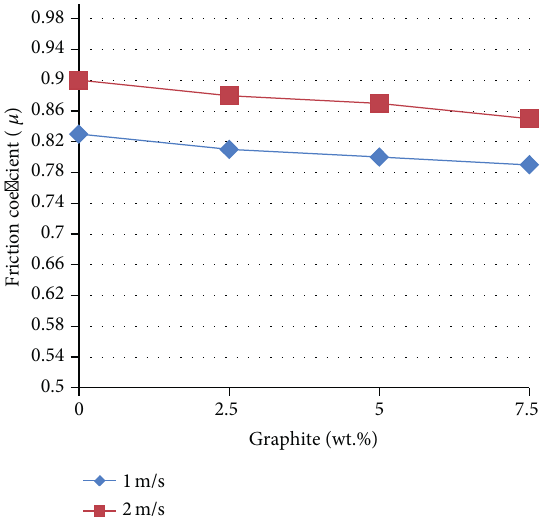
Figure 9: Variation of friction coefficient as a function of graphite content and sliding velocities of 1m/s and 2 m/s at constant normal load of 49N.